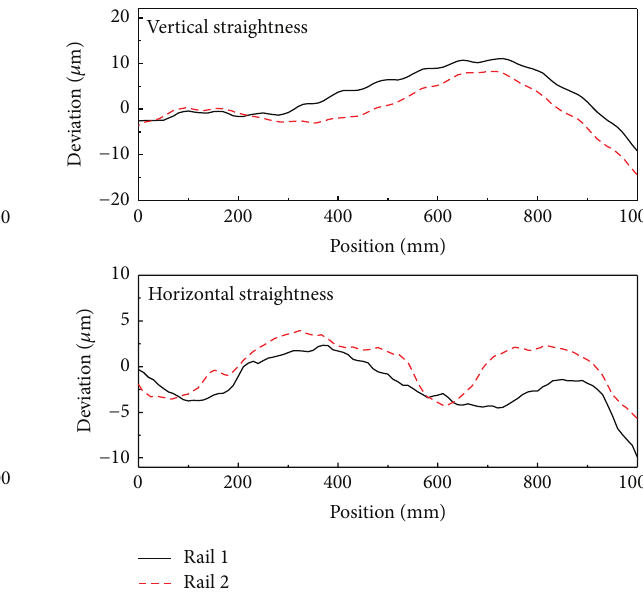
Figure 14: Straightness errors before and after compensating for parallelism errors.